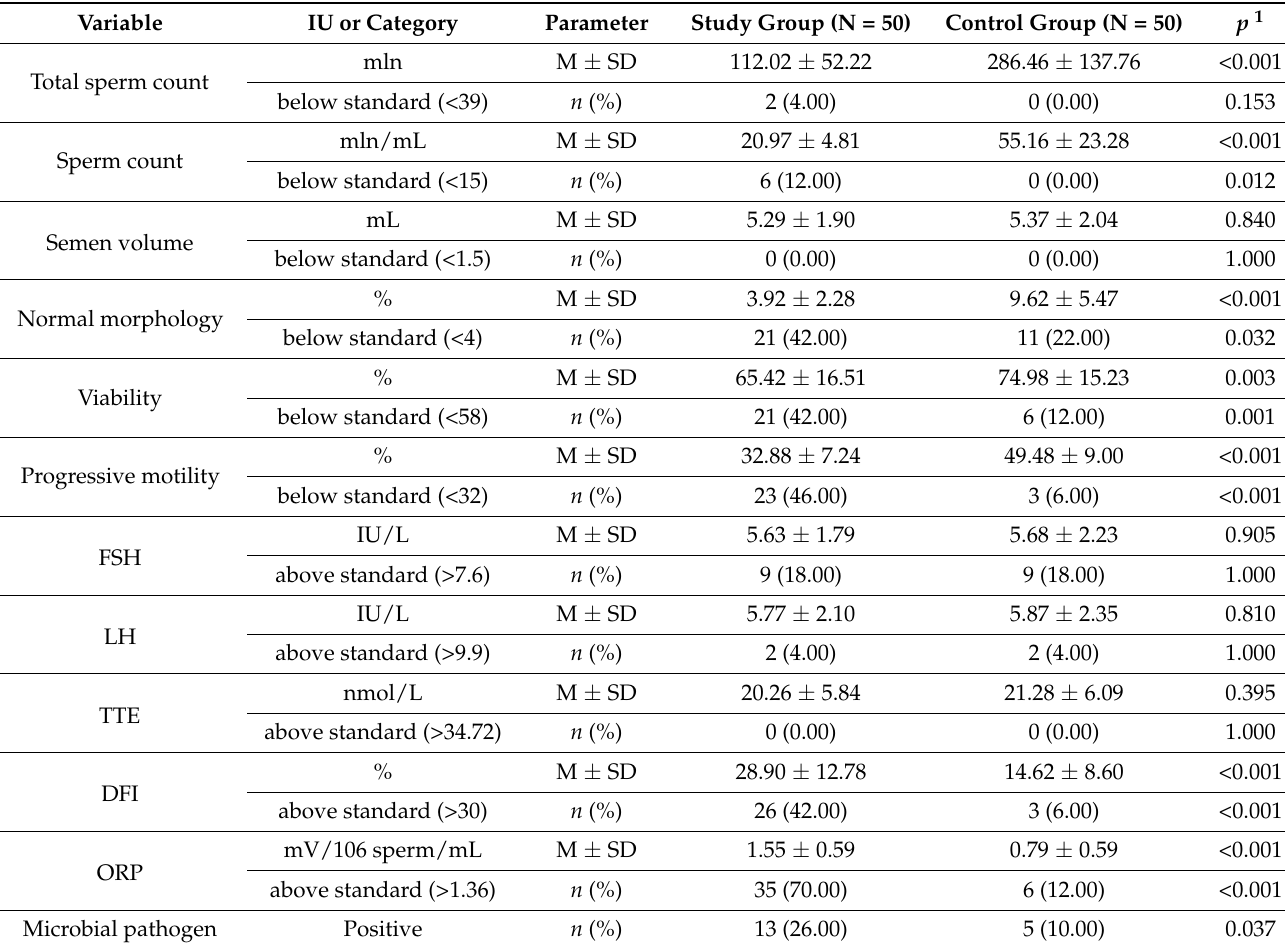
Table 2. Semen parameters and sex hormones compared between the study group and the control